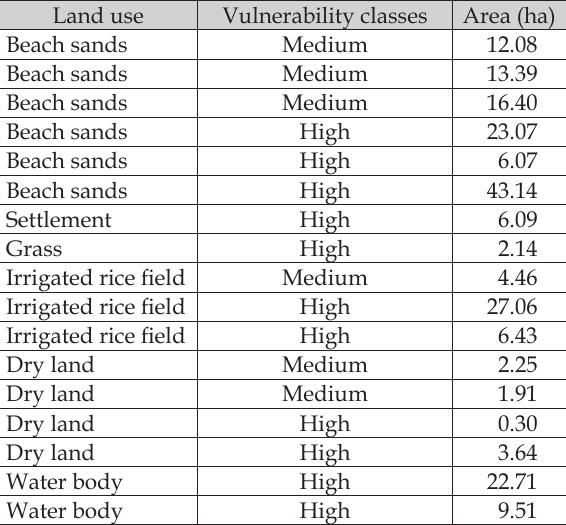
Table 3. The extent of susceptible area to coastal ero - sion based on land